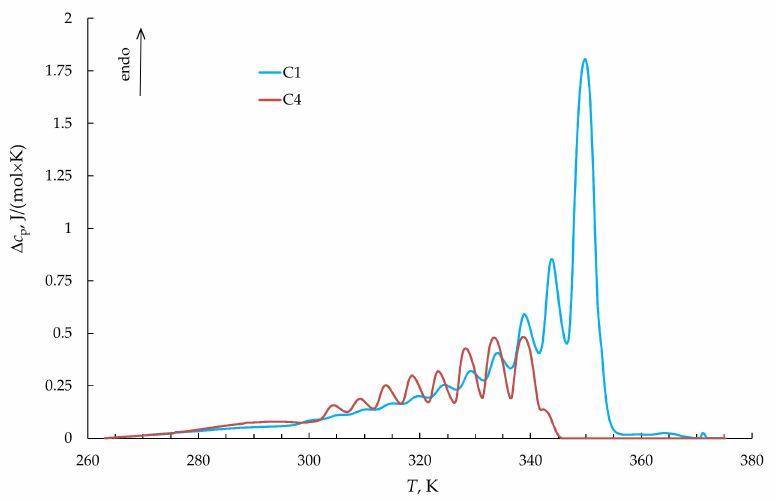
Figure 6. Melting curves of thermally fractionated (blue) C1 and (brown) C4 NB–CDD copolymers normalized for the trans CDD unit content.